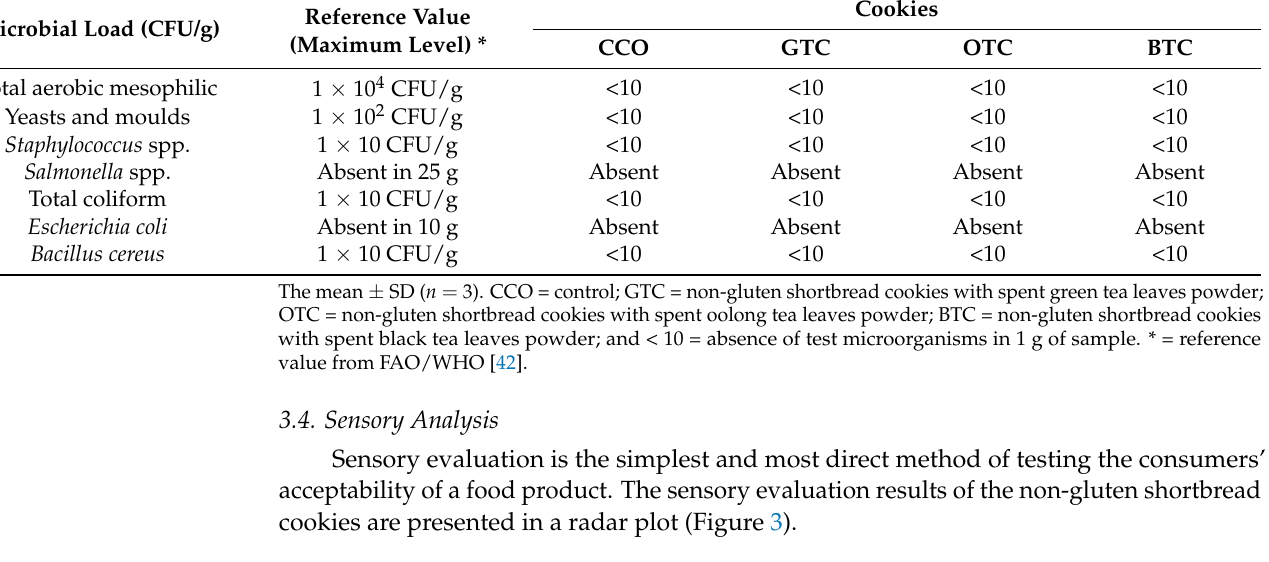
Table 7. Microbiological quality of non-gluten shortbread cookies with various spent tea leaf powders. Microbial Load